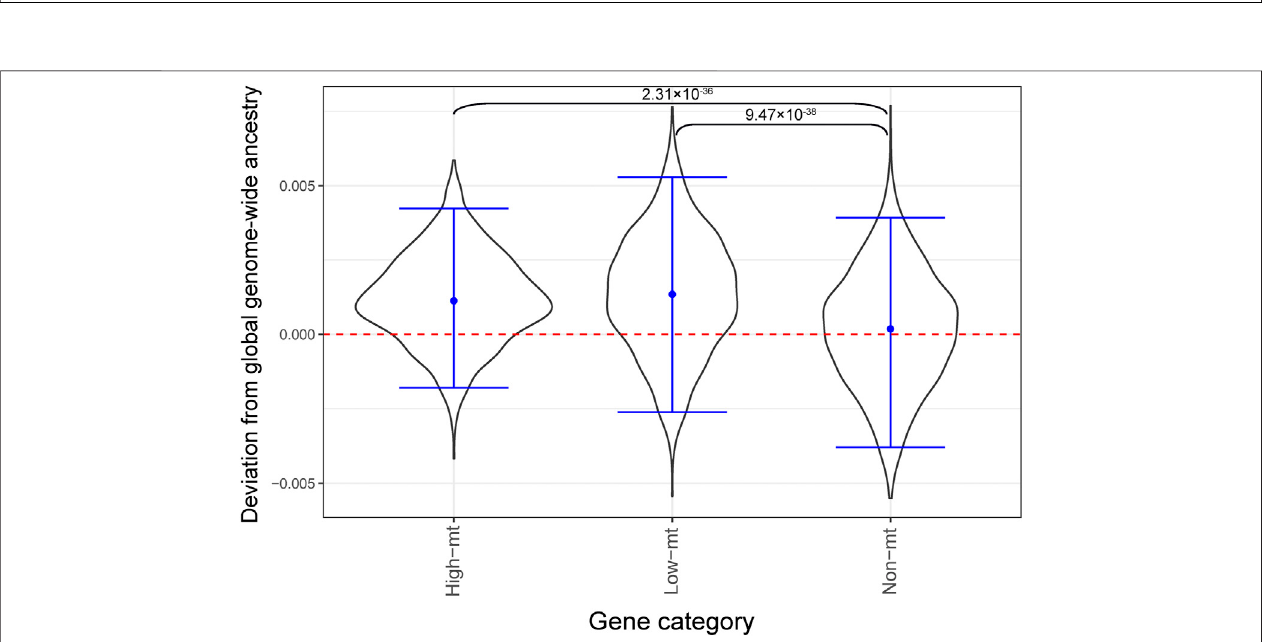
FIGURE 5 | Local ancestry enrichment for African ancestry in African Americans from the GTEx dataset. The Y axis shows local ancestry deviation and the X axis shows functional categories (high-mt: 167 genes, low-mt: 793, non-mt: 17,456 genes, see text for details). A block bootstrap approach (see Methods) was used to generate the distributions of deviation from global ancestry. Blue horizontal bars show the empirical 95% CI of the mean ancestry deviation. The p -values correspond to a t -test of independent means comparing mean local ancestry deviations at non-mt genes to those at high-mt and low-mt